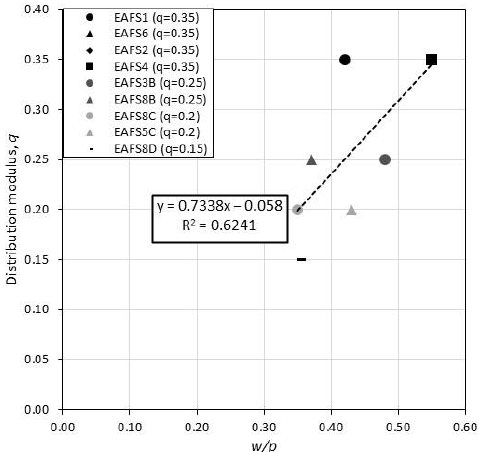
Figure 16. Evolution of distribution modulus, q , with respect to the water/powder ratio, w / p .